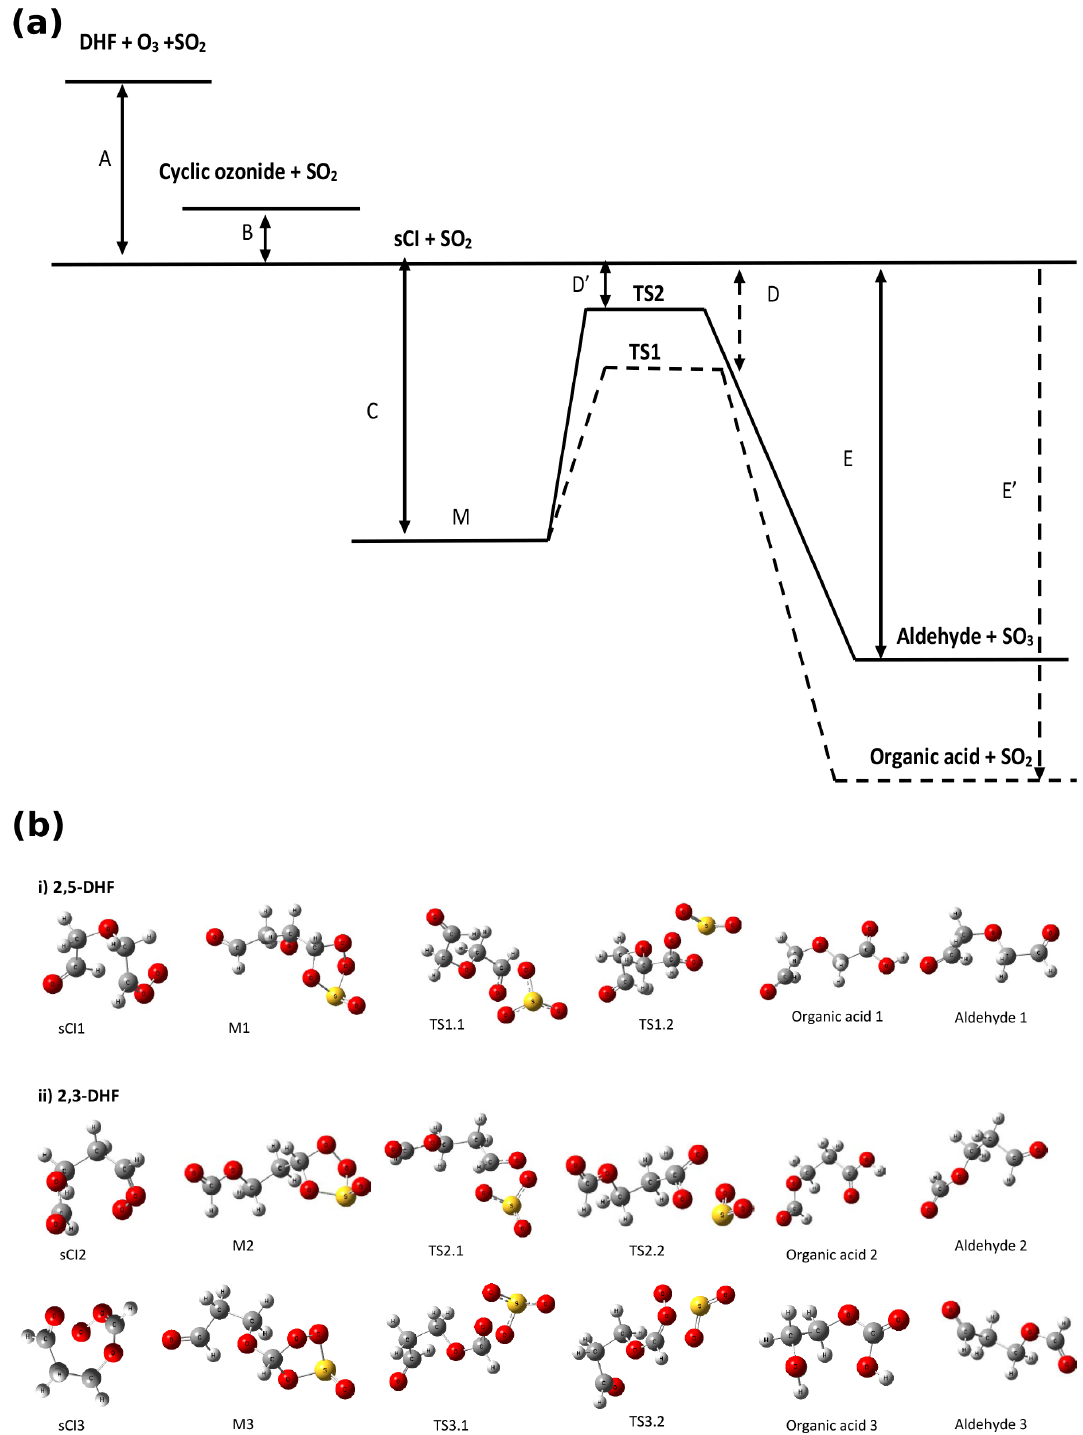
Figure 5. (a) General schematic potential energy surface for the reactions sCI + SO 2 → products. (b) Geometries of stationary points involved in the sCI + SO 2 reaction at the BMK/6-311 ++ G(3df,3pd) level of